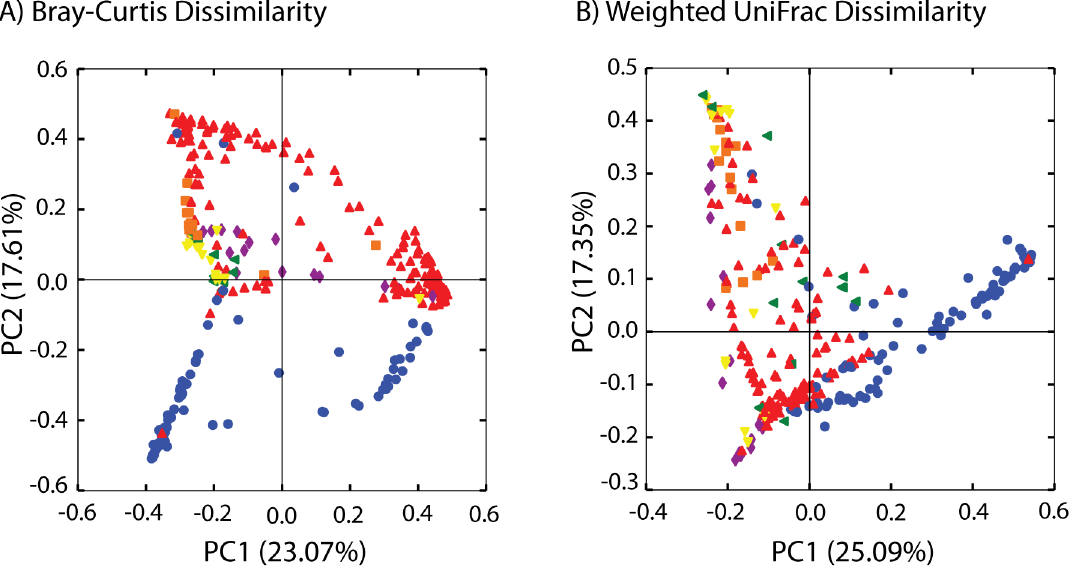
Fig 3. Principal coordinate analysis (PCoA) of flea-associated bacterial communities based on flea species. PCoA was performed based on Bray- Curtis dissimilarities (A) and on weighted UniFrac distances (B). The percentage of variation explained by axes one and two are presented in parentheses. Green: Ctenophthalmus calceatus cabirus , Purple: Dinopsyllus lypusus , Yellow: Stivalius torvus , Blue: Xenopsylla brasiliensis , Red: Xenopsylla cheopis , Orange: Xenopsylla nubica .